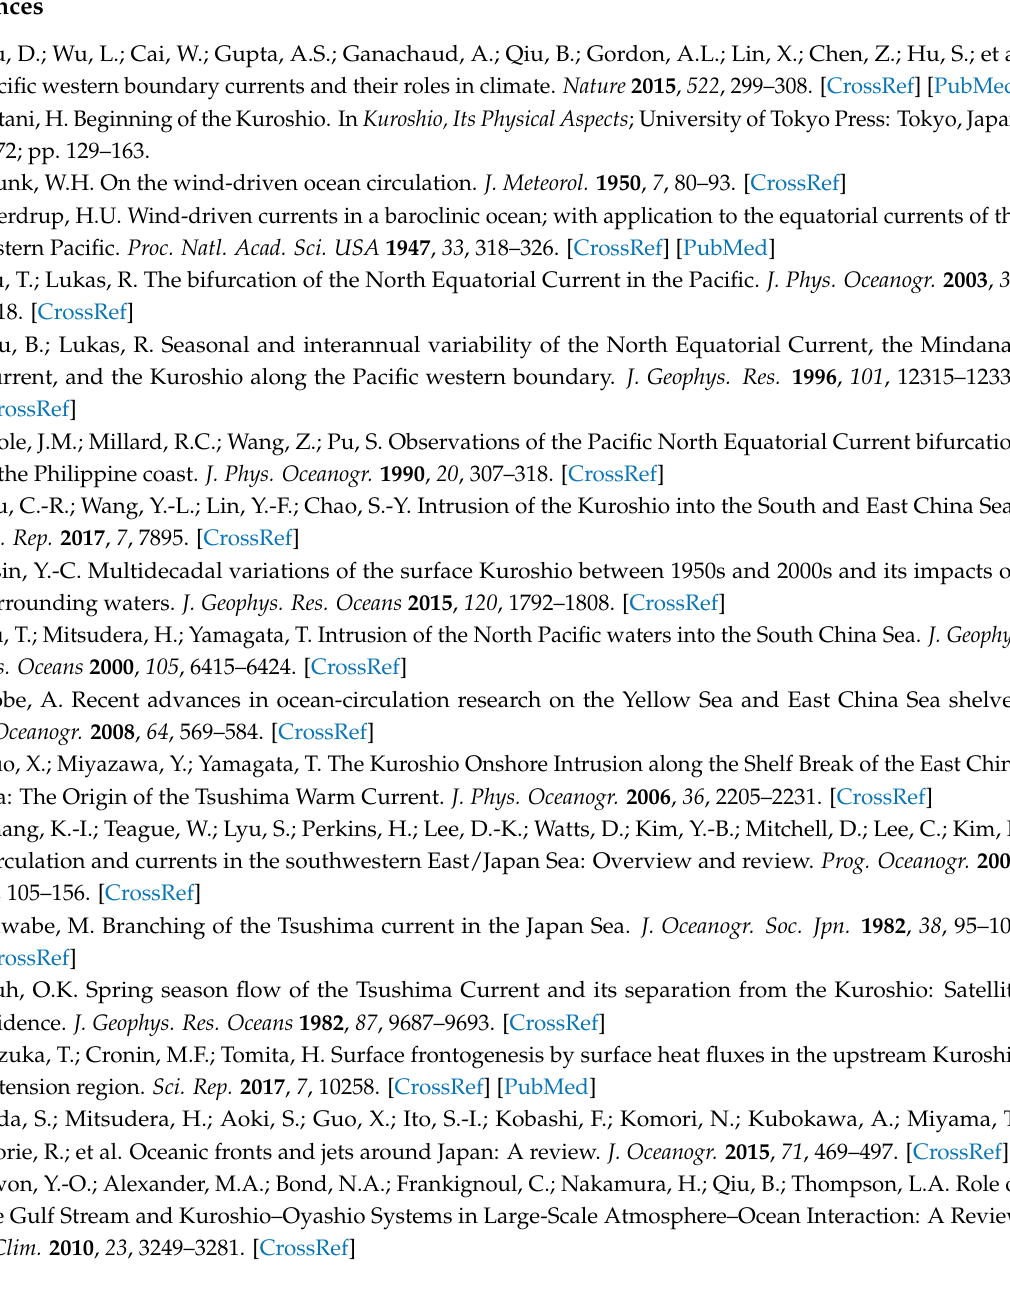
Figure S1: Estimation for the path of the Kuroshio extension jet, Figure S2: Mean SSH and velocity together with their difference, Figure S3: Spatial pattern of SSH and velocity